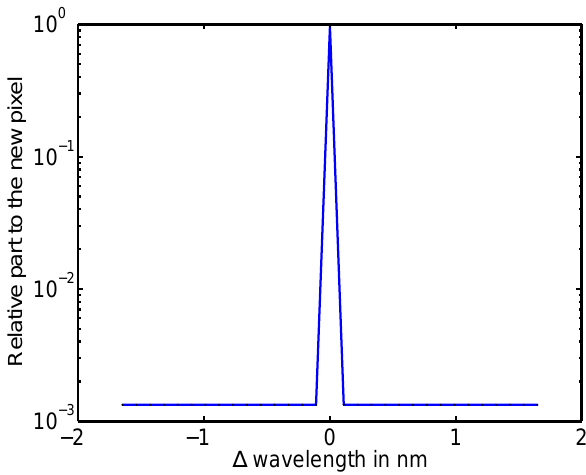
Fig. 6. Result of the Ring effect correction for a tangent altitude of 53.5km for the ratio I/F . Shown are the uncorrected spectrum and the corrected spectra with different percentages of Raman scattering in the applied method. The emission signals become smaller with this correction and the Mg line at 285.2nm as well as the Si line at 288nm, which cannot be observed in the region between 90 to 100km and originates probably purely from Ring effect, nearly van- ish for the Ring correction with 4% of inelastic scattering in the background